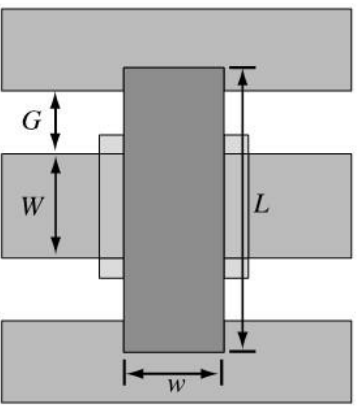
Figure 1. MEMS capacitive parallel switch top view.